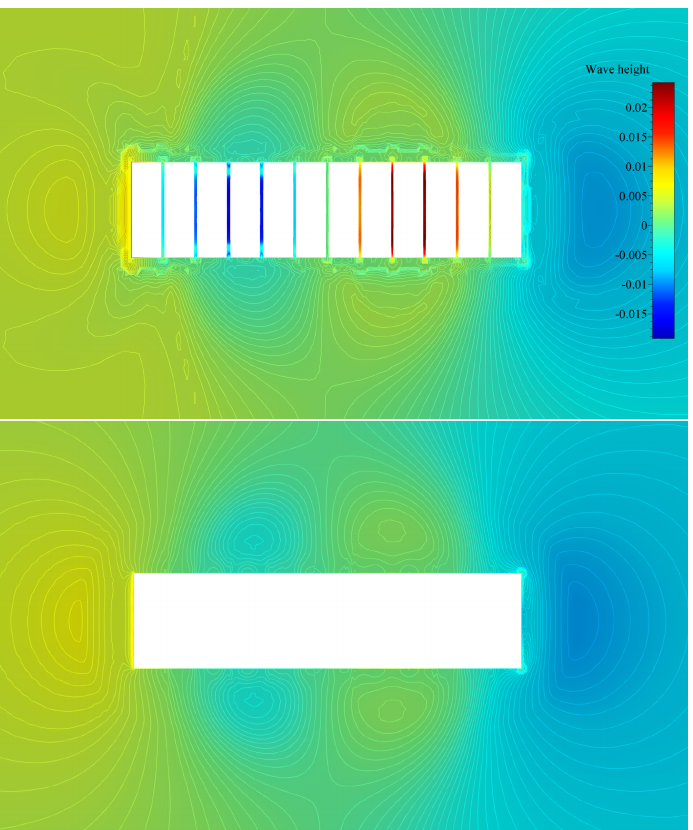
Figure 6. Top view of free surface elevation contours for the second mode of vertical vibration (segmented hull—top image, monohull—bottom image).